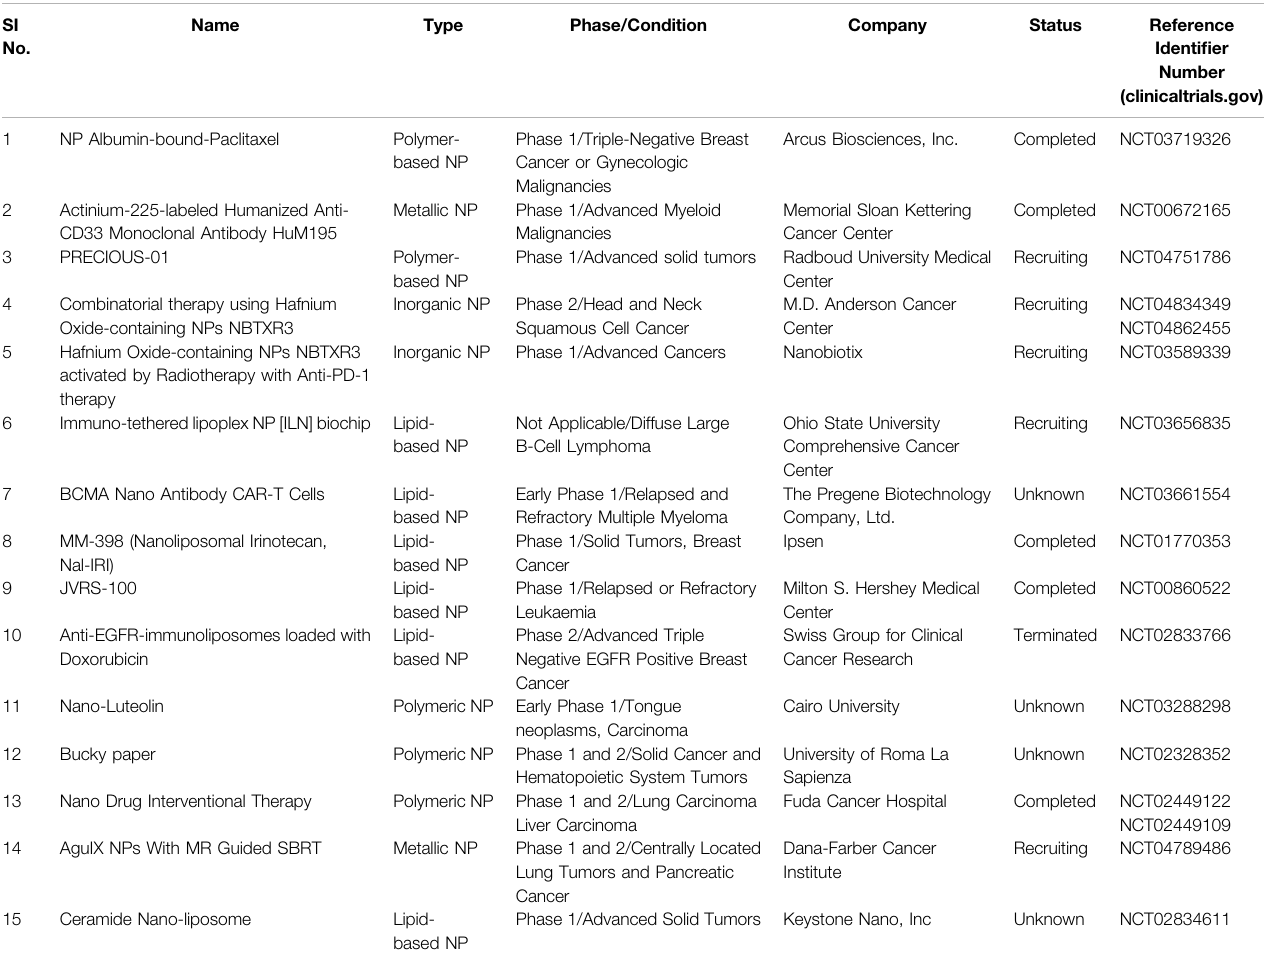
TABLE 1 | A summary of the nano-immunotherapeutic agents in clinical trials. SI